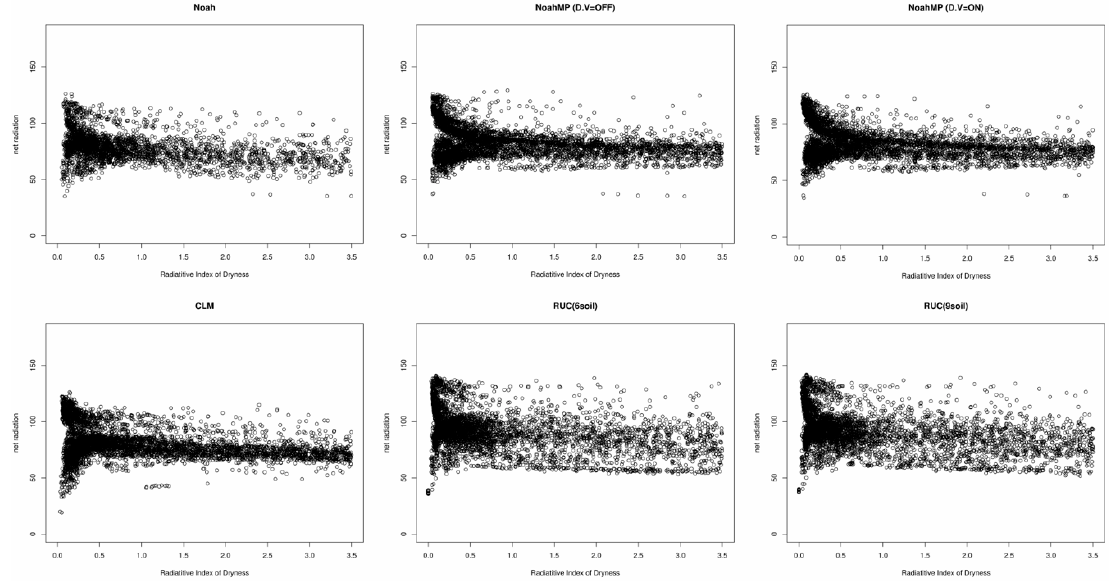
Figure 4. Annual means of Radiative Index of Dryness (x-axis) vs. annual means of net radiation (y- axis).